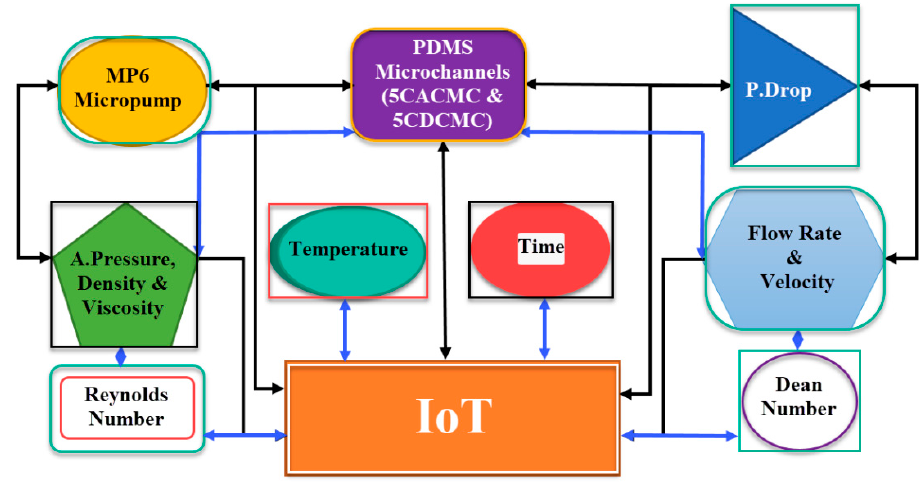
Figure 1. Internet of things (IoT) Controlled Microfluidic System.